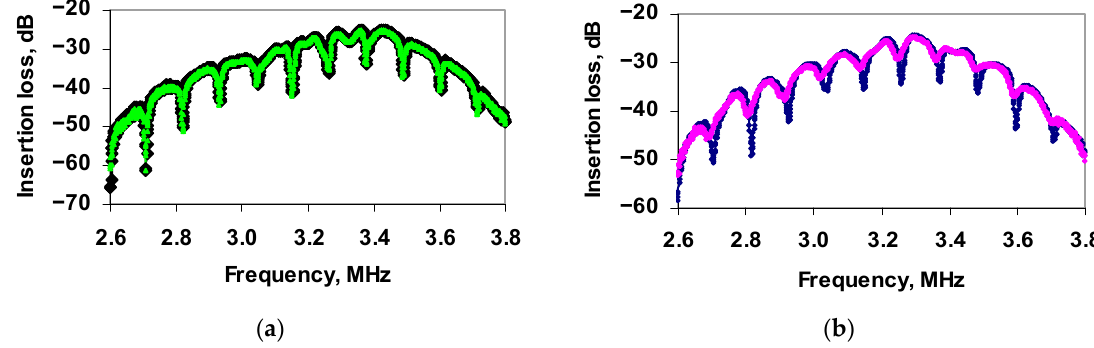
Figure 7. Frequency dependences of the insertion loss of the sensor for distilled water: ( a ) without viruses (black curve) and with TGE viruses (green curve), and ( b ) with TGE viruses before (blue curve) and after (pink curve) adding Ab TGEV .